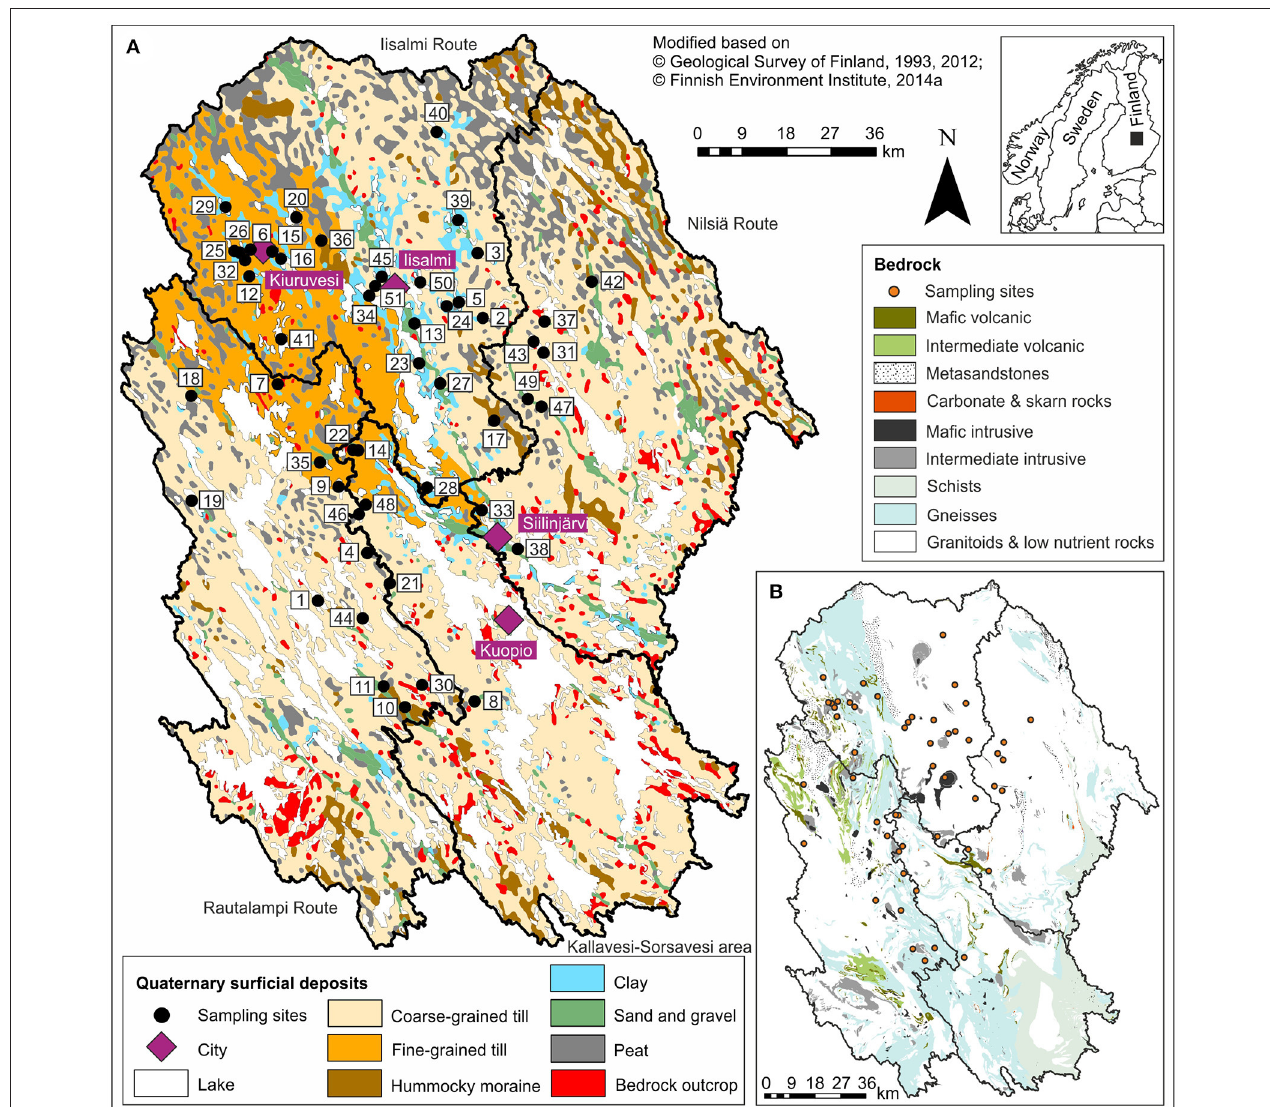
FIGURE 1 | A map showing the location (inset), (A) the surficial geology, and (B) the crystalline bedrock of the study area together with the sampling sites and the catchments of the four watercourses. See Table 1 for the names and locations of the lakes.